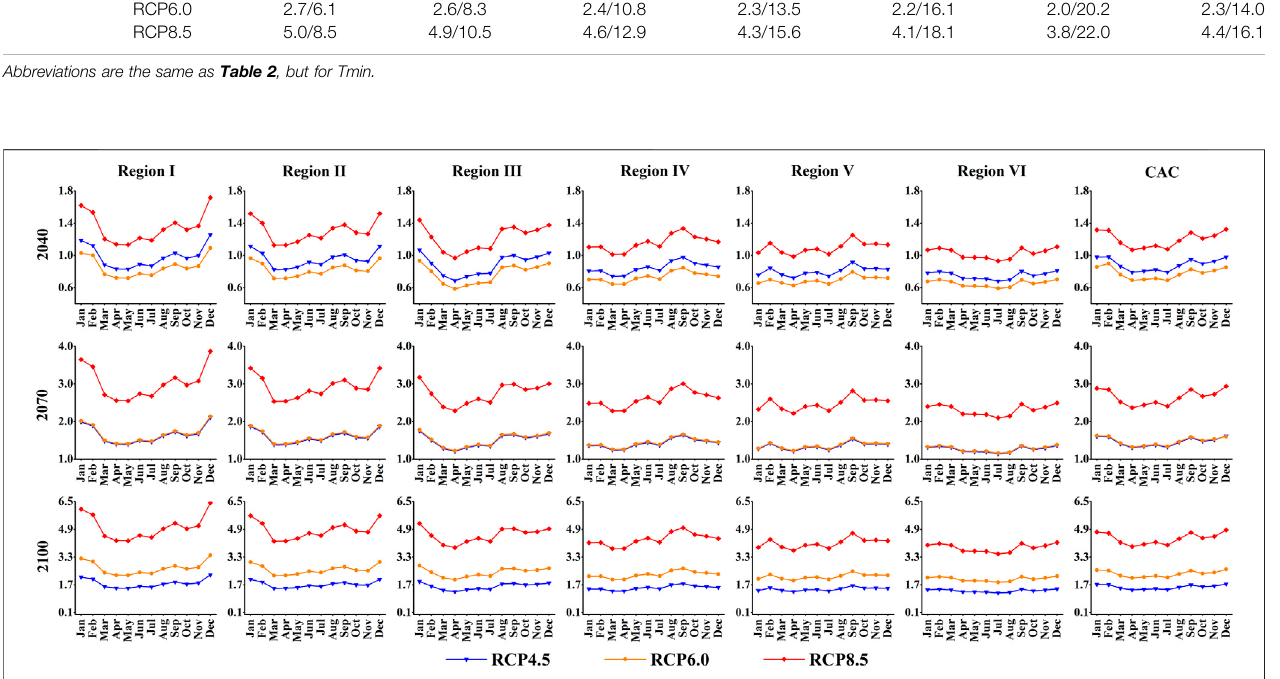
FIGURE 7 | Changes in monthly average Tmin for 2040, 2070, and 2100 with different RCPs relative to the base period 1996 – 2018 over CAC.